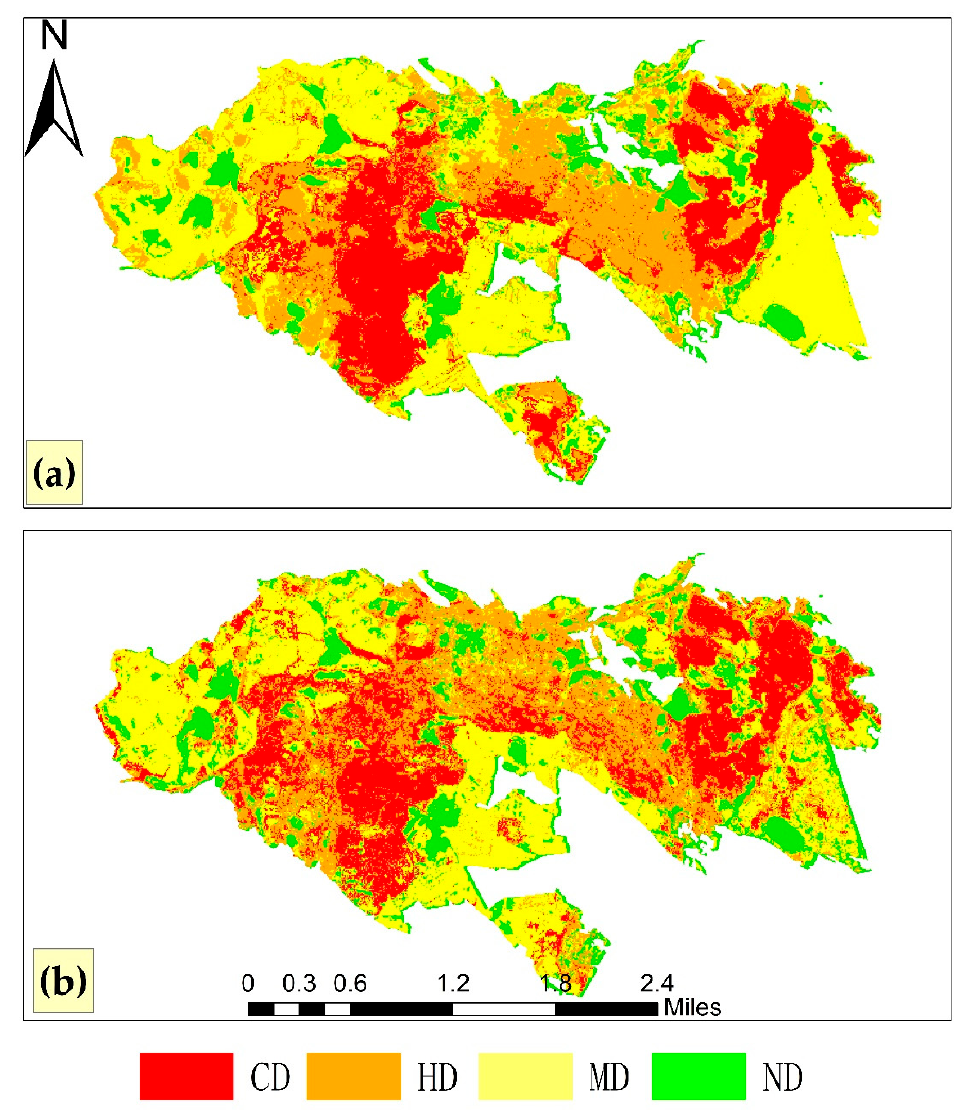
Figure 8. Comparison of EMSR171 fire severity mapping results of ( a ) BAP method; ( b ) SI method.